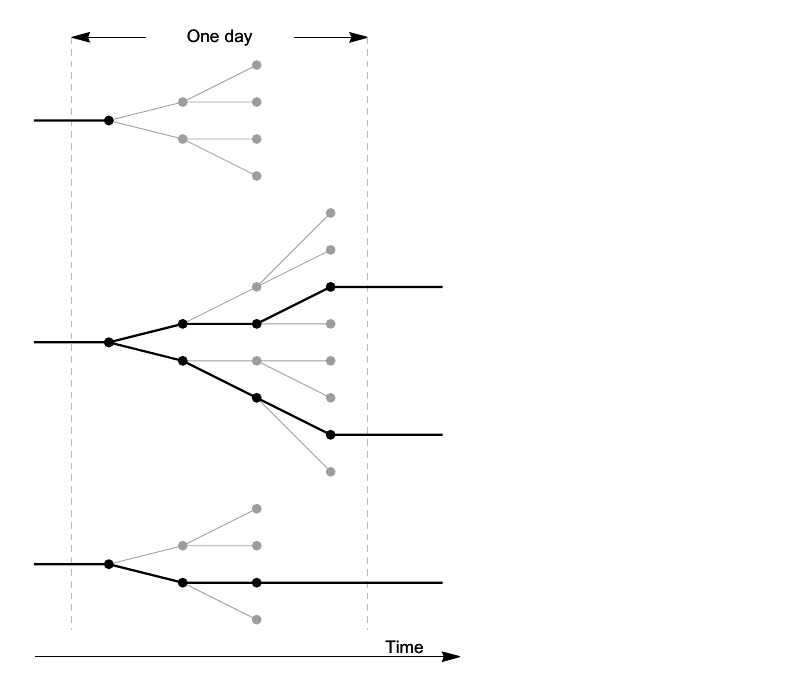
Figure 1. Phylogenetic representation of one day evolution in the LTEE. After a few clonal divisions (2–3 in the figure, 6–7 in the experiment) individuals are randomly selected to pass to the next day. Most lineages are truncated, whereas those with higher fitness have better possibilities to continue to the next day.